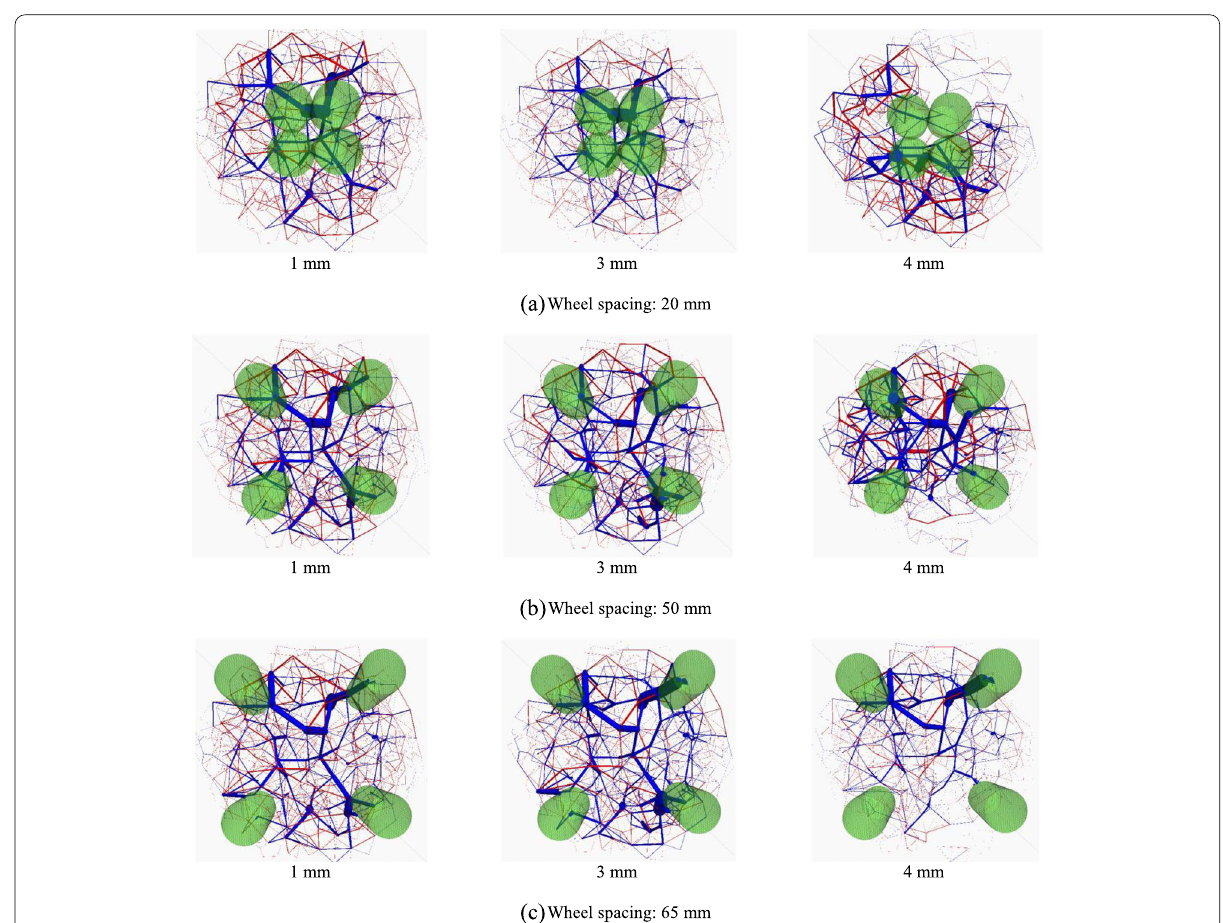
Fig. 17 Distribution of force chains under different wheel spacings. ( a ) Wheel spacing: 20 mm. ( b ) Wheel spacing: 50 mm. ( c ) Wheel spacing: 65